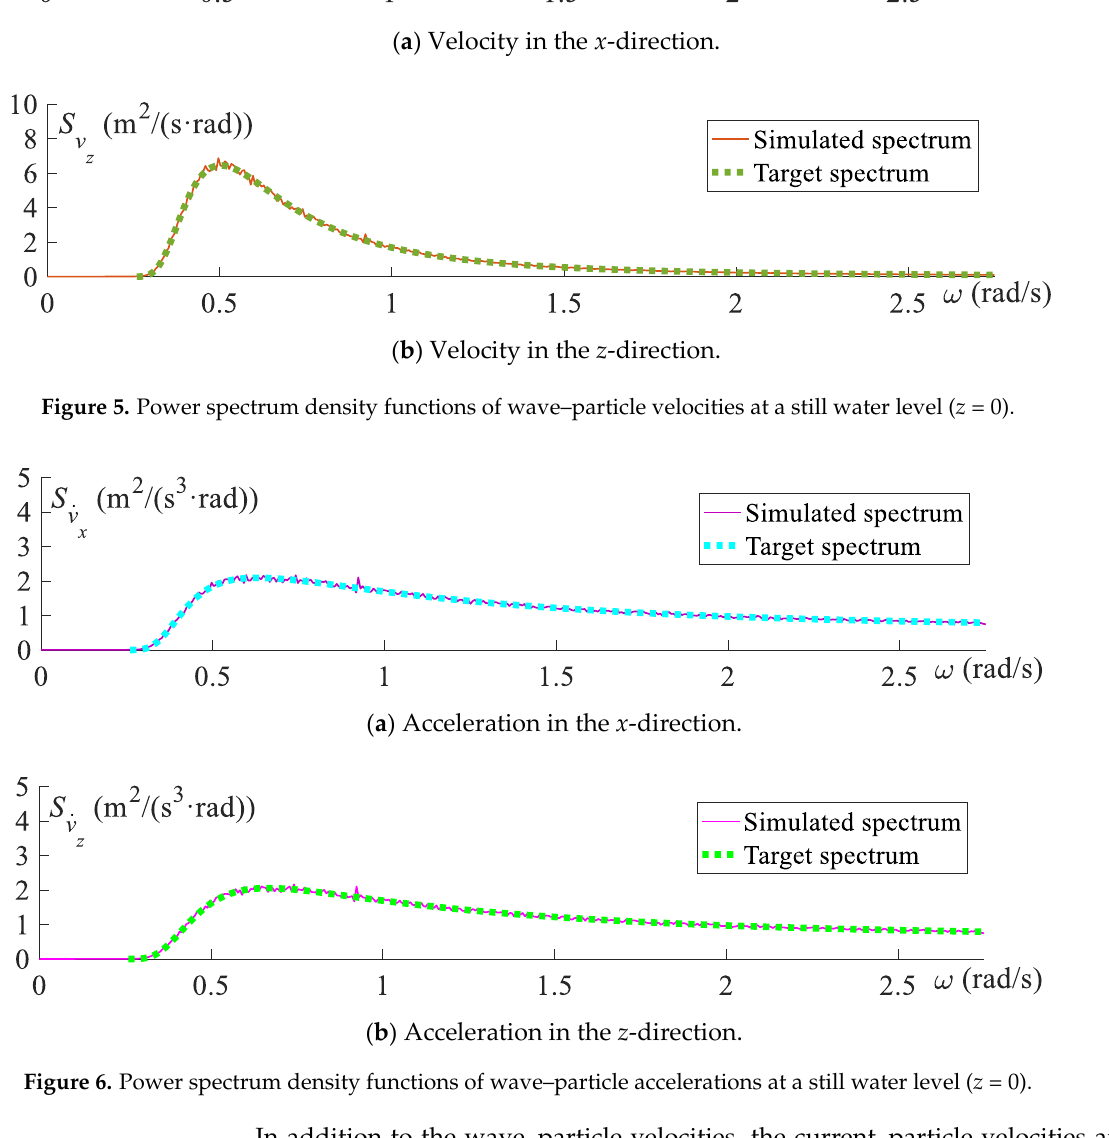
( a ) Velocity in the x -direction.